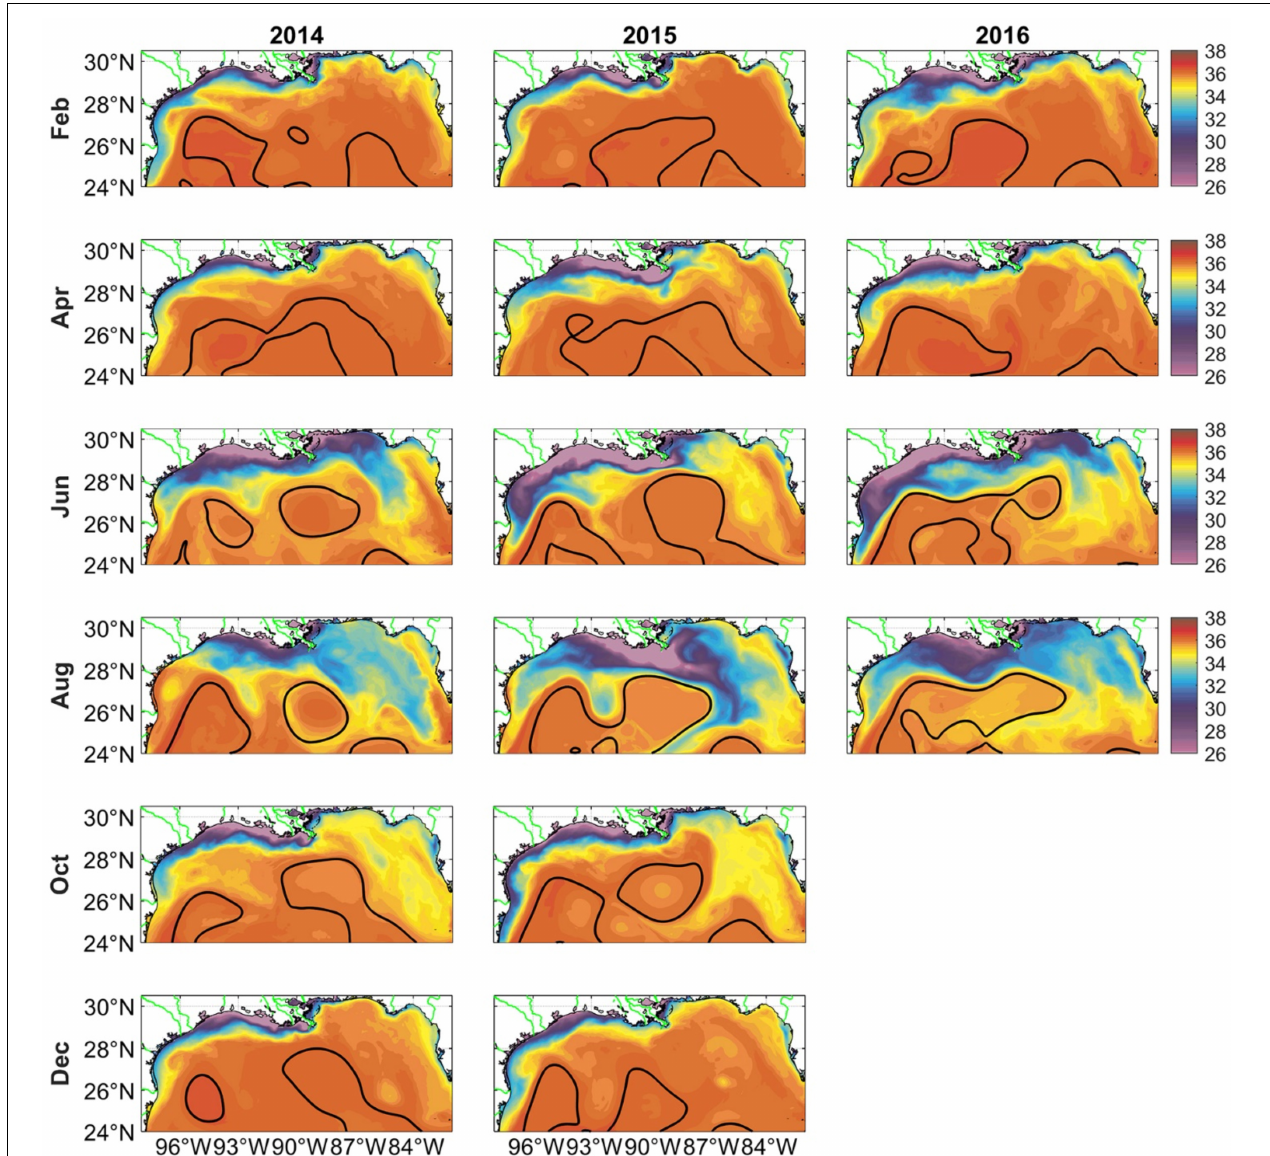
FIGURE 2 | Monthly averaged surface salinity in the first member (initialized on the 1st of the month) of the SP active case shown in the third (February, June, and October) and fifth (April, August, and December) months of the (free) simulation. Black contour indicates 0.17 m sea surface height anomaly (SSHa) and broadly follow the LCS and the Rings, following Leben and Born